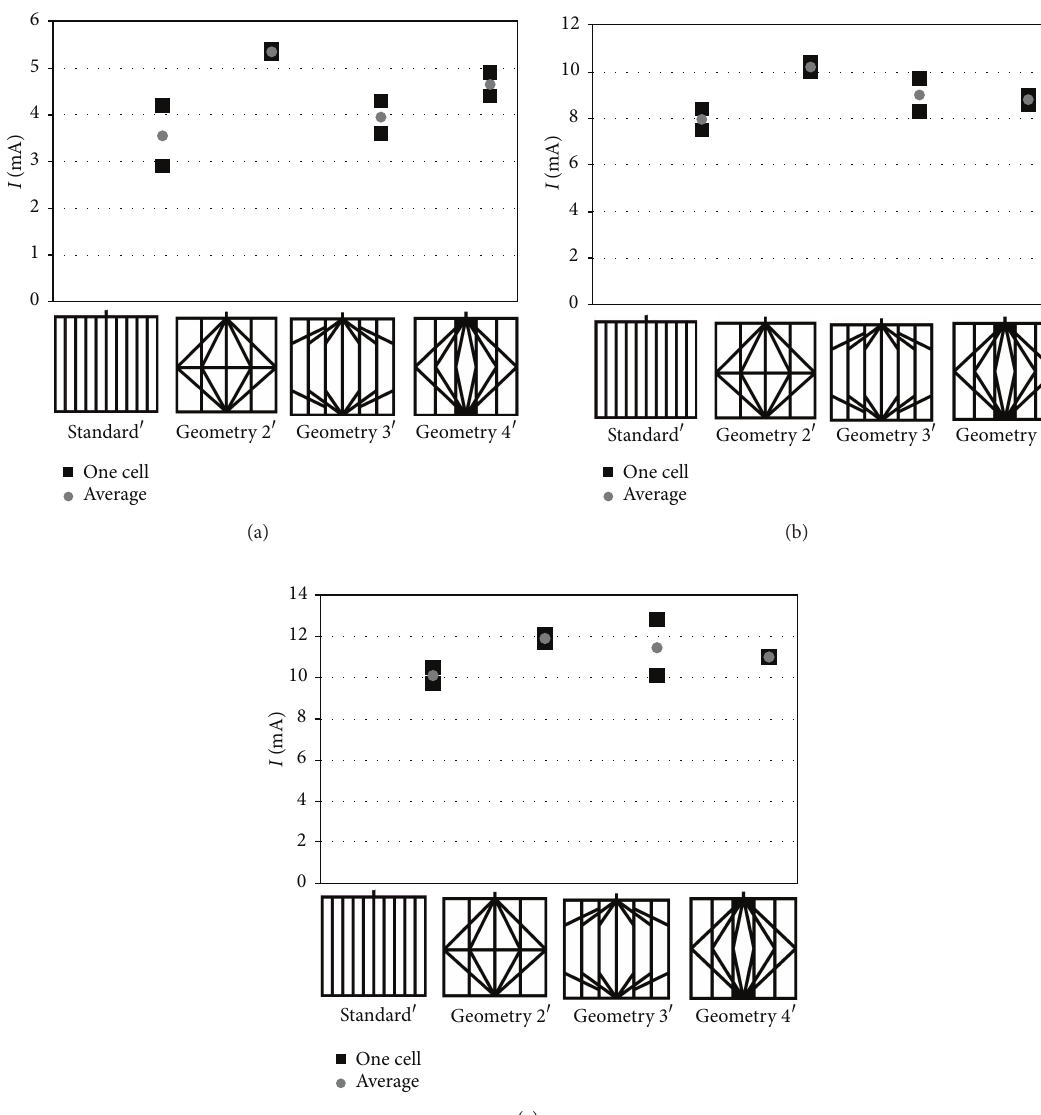
Figure 14: Experimental results for the four geometries at (a) 𝑉 = 2.0 V, (b) 𝑉 = 2.4 V, and (c) 𝑉 = 2.7